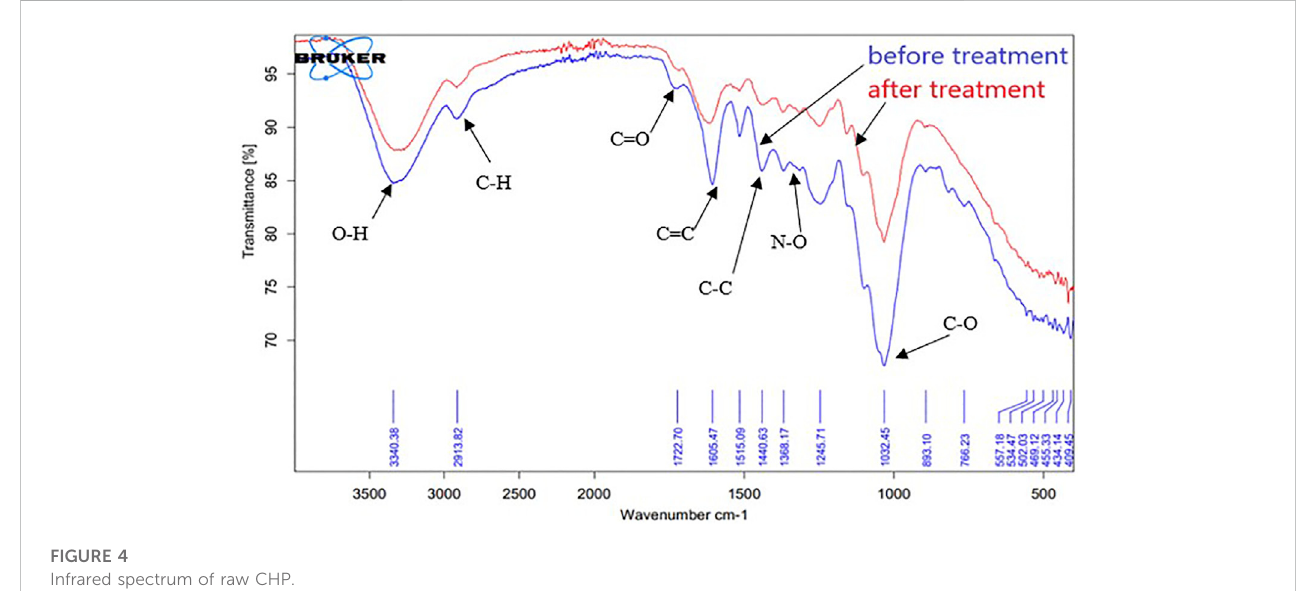
FIGURE 4 Infrared spectrum of raw CHP.